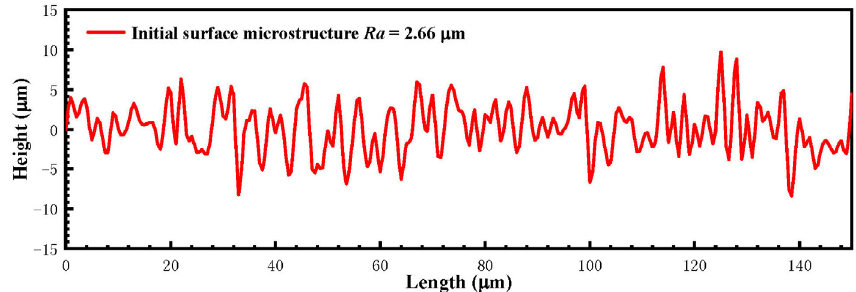
Fig. 2 The initial surface micro-profile of